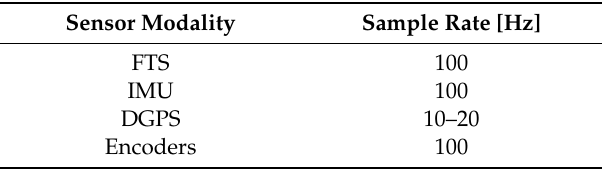
Table 2. Sensor sample